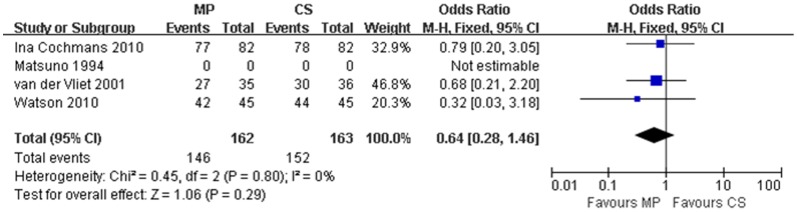
One year graft survival for DCD kidneys preserved by MP versus CS.Pooled estimate of odds ratio (OR) and 95% confidence intervals (CIs) of one year graft survival for DCD kidneys preserved by MP on 4 studies. Squares indicate OR in each study. The square size is proportional to the weight of the corresponding study; the length of horizontal lines represents the 95% CI. The rhombus indicates the pooled OR and 95% CI (fixed-effect model).